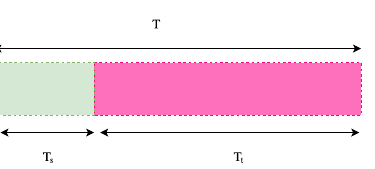
Figure 8. Activity period of SU under HD functioning is divide into Sensing sub-period ( T